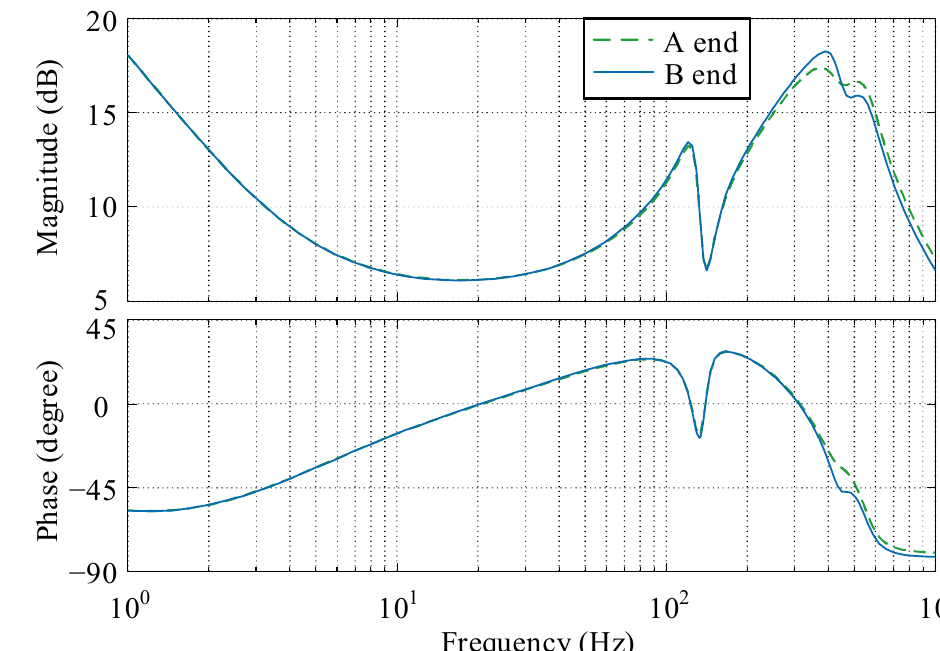
Figure 11. Bode diagram of the μ -controller. Additionally, the sensitivity function of the closed-loop system under the μ - controller with uncertain modal frequency is shown in Figure 12. The sensitivity peaks of the system at the A end and B end are 8.31 and 8.25 dB, respectively. Although the uncertainty exits, the μ -controller still has good performance and the sensitivity function falls within Zone A according to ISO 14839-3.